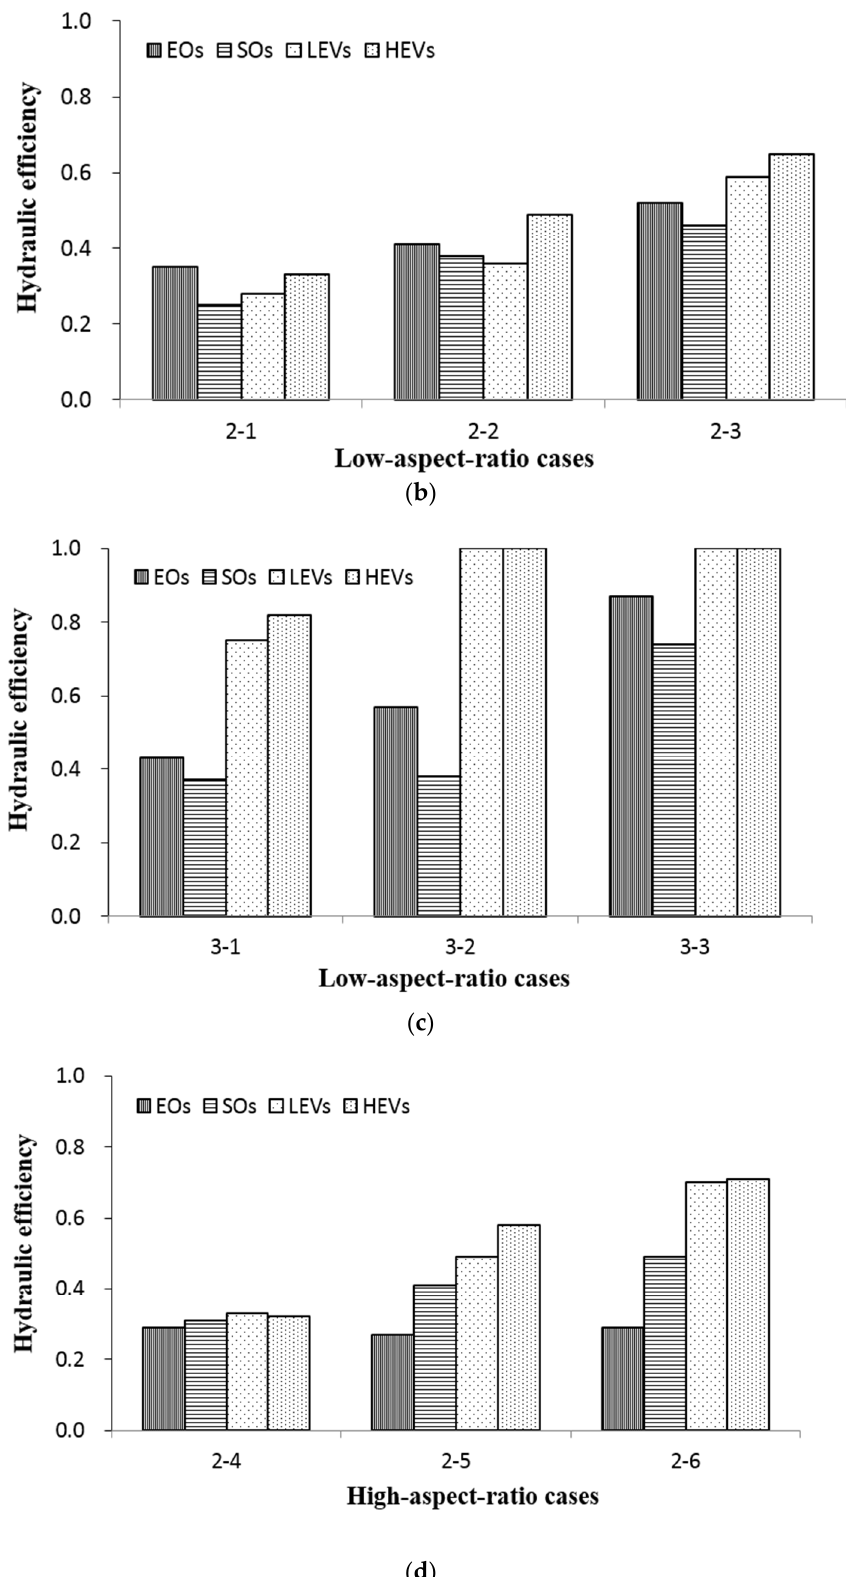
Figure 6. Hydraulic performance of ( a ) low-aspect-ratio cases 1-1, 1-2, and 1-3; ( b ) low-aspect-ratio cases 2-1, 2-2, and 2-3; ( c ) low-aspect-ratio cases 3-1, 3-2, and 3-3; and ( d ) high-aspect-ratio cases 2-4, 2-5, and 2-6 with emergent obstructions, submerged obstructions, and high- and low-density emergent vegetation.